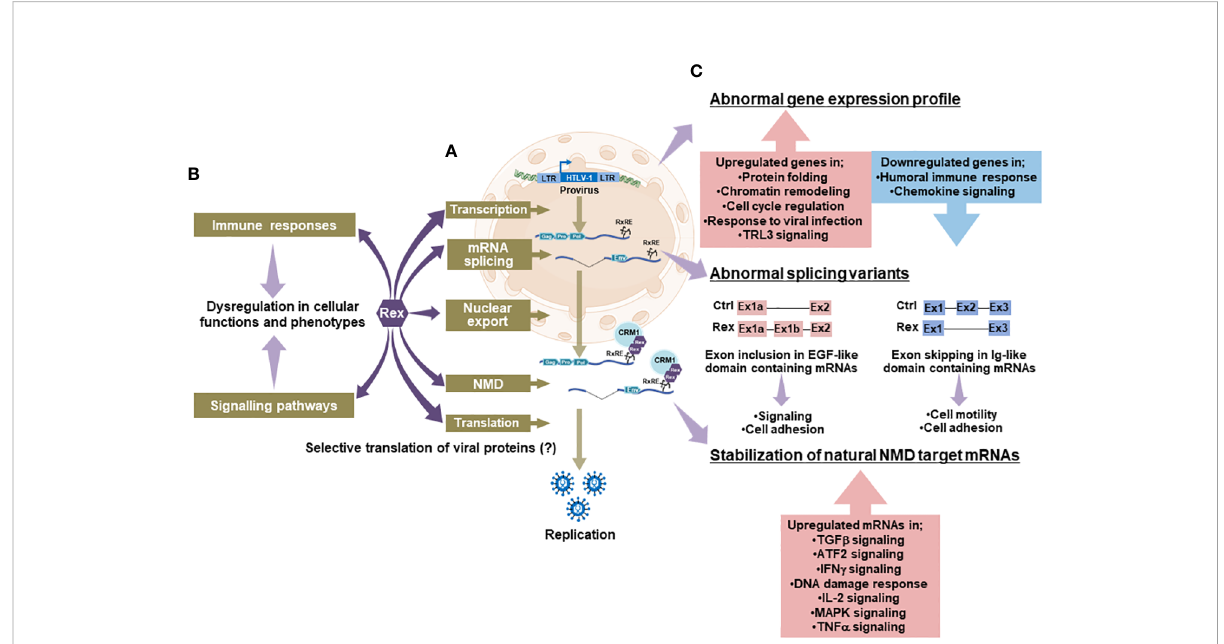
FIGURE 5 Novel aspects of Rex and its effects on cellular pathways; (A) The interactome analysis between Rex and human cellular proteins revealed that Rex interacts with proteins involved in cellular pathways from transcription to translation (arrows in deep purple). Especially, Rex shows interactions with many ribosomal proteins, indicating a possible involvement of Rex in the host translational pathway. (B) Rex also interacts with proteins involved in immune response and signaling pathways (arrows in deep purple), suggesting that Rex may alter T cell functions and phenotypes by affecting these intracellular pathways (arrows in light purple). (C) Rex-overexpressing T cells showed alterations in a wide range of gene expression pro fi les (arrows in light purple). In the Rex expressing cells, the genes involved in the regulation of gene expression, cell cycle, and viral infection response are upregulated, while those involved in the humoral immune response and chemokine signaling pathway are downregulated. In addition, changes in splicing patterns were observed in various mRNAs in Rex expressing T cells (arrows in light purple). Particularly, exon inclusion in mRNAs encoding EGF-like domains and exon skipping in mRNAs encoding Ig-like domains are observed in high frequencies. In addition, the expression levels of natural NMD target mRNAs involved in various signaling pathways were elevated in Rex expressing T cells (arrows in light purple), possibly because of the NMD inhibitory function of Rex. Generated using Servier Medical Art, provided by Servier, licensed under a Creative Commons Attribution 3.0 unported